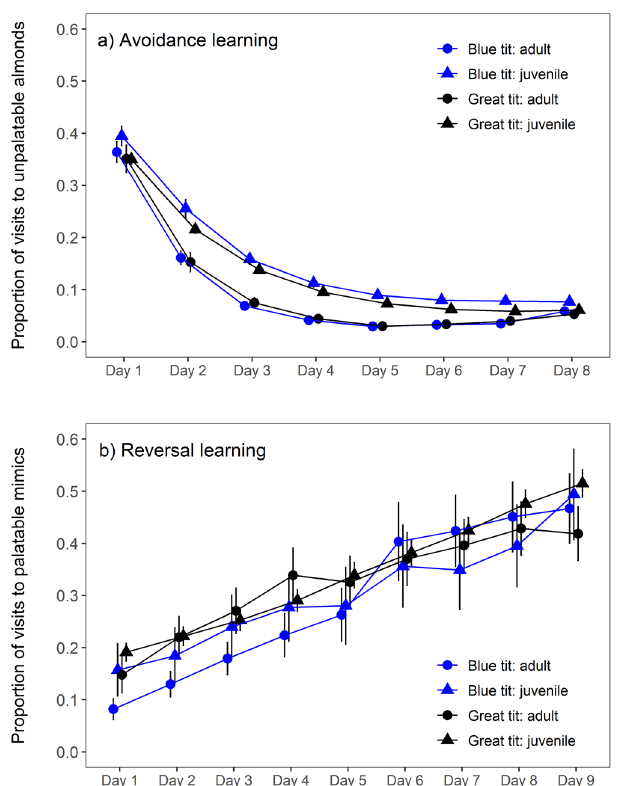
Fig. 2 Learning across days. The proportion of visits ( a ) to the unpalatable feeder in the avoidance learning experiments ( n = 189 birds) and ( b ) to the feeder with palatable mimics in the reversal learning experiment ( n = 118 birds). Graphs show the mean (±s.e.) proportion of visits across the days of the experiment (number of visits to each feeder divided by the total number of visits). All three avoidance learning experiments (red/green, blue/ purple, and yellow/orange) are combined in the graph ( a ). Circles indicate the foraging choices of adults and triangles show the choices of juveniles (blue: blue tits, black: great tits). The plotted data were derived from the generalized linear mixed-effects